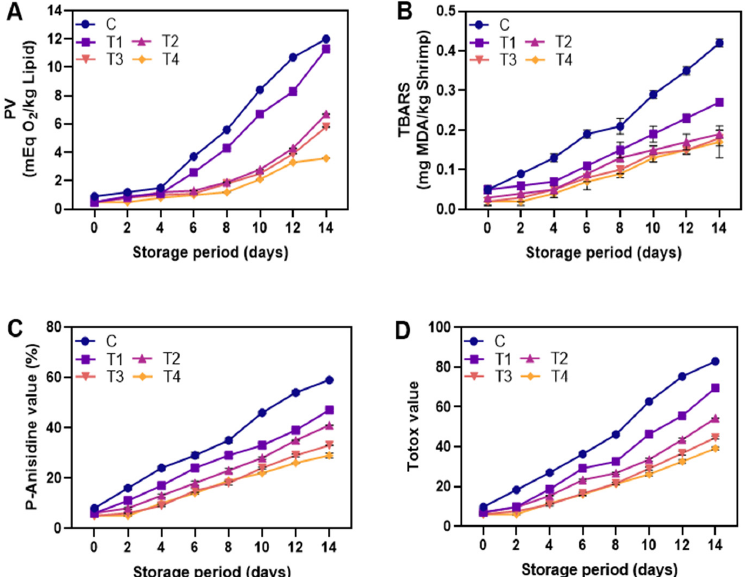
Figure 7. Changes in PV ( A ), TBARS ( B ), p-anisidine value ( C ), and totox value ( D ) of the shrimp coated with different coating during storage of 14 days at 4 °C. C: shrimp dipped in distilled water as control; T1: shrimp coated with alginate coating; T2, T3, and T4: shrimp coated with 0.5, 1.0, and 1.5% LPE, respectively.